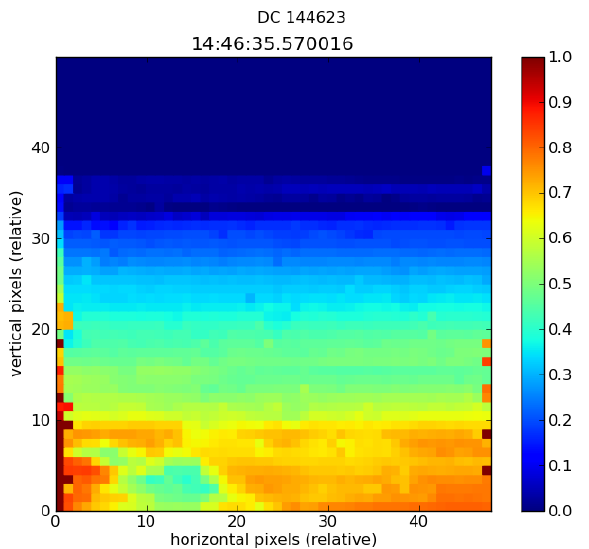
Figure 2. Direct current signal (arbitrary units) for one GLORIA image, before the Fourier transformation is applied. Exposure time is 40ms and the horizontal extent is about 7.5km at 10km tangent altitude.